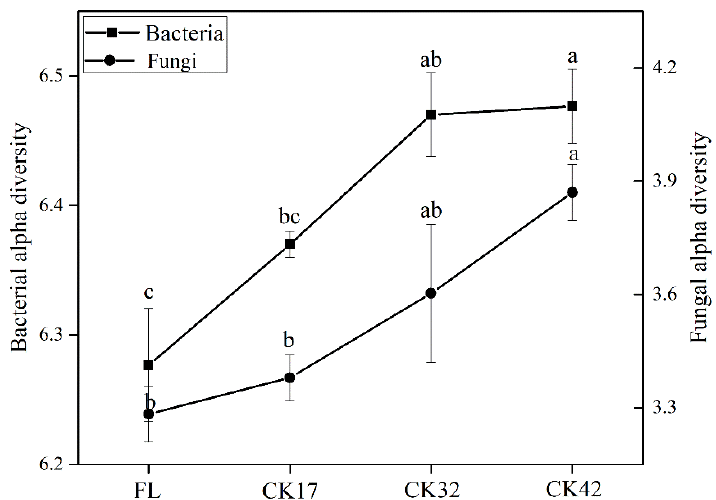
Figure 2. The alpha diversity of soil bacterial and fungal communities among di ff erent stages of vegetation restoration. Error bars indicate the standard errors of the means. Means with di ff erent lowercase letters indicate significant di ff erences among di ff erent stages of vegetation restoration based on one-way ANOVA followed by an LSD test ( p < 0.05).